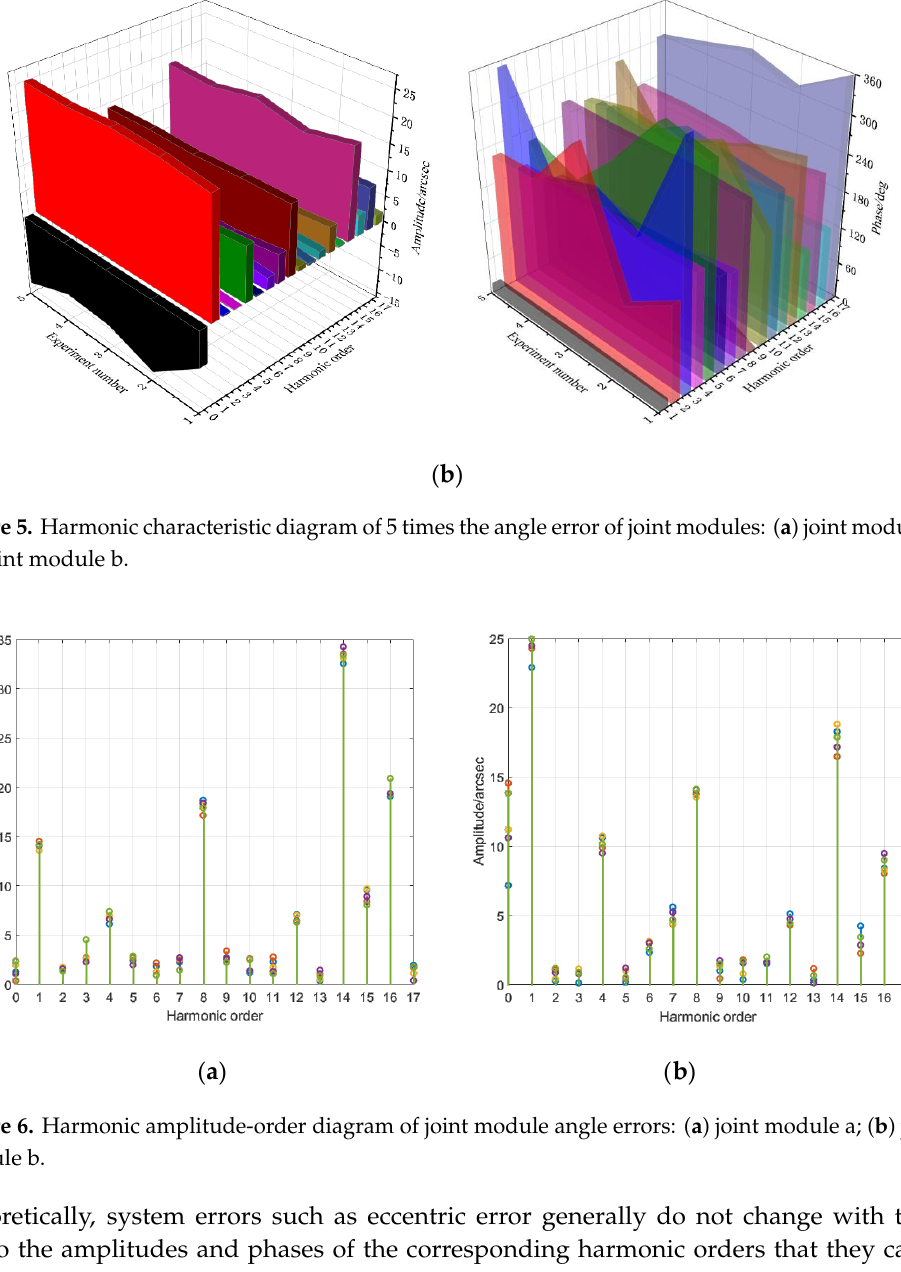
Figure 7. Phase range of harmonics in each order of angle error of joint modules: ( a ) joint module a; ( b ) joint module b.